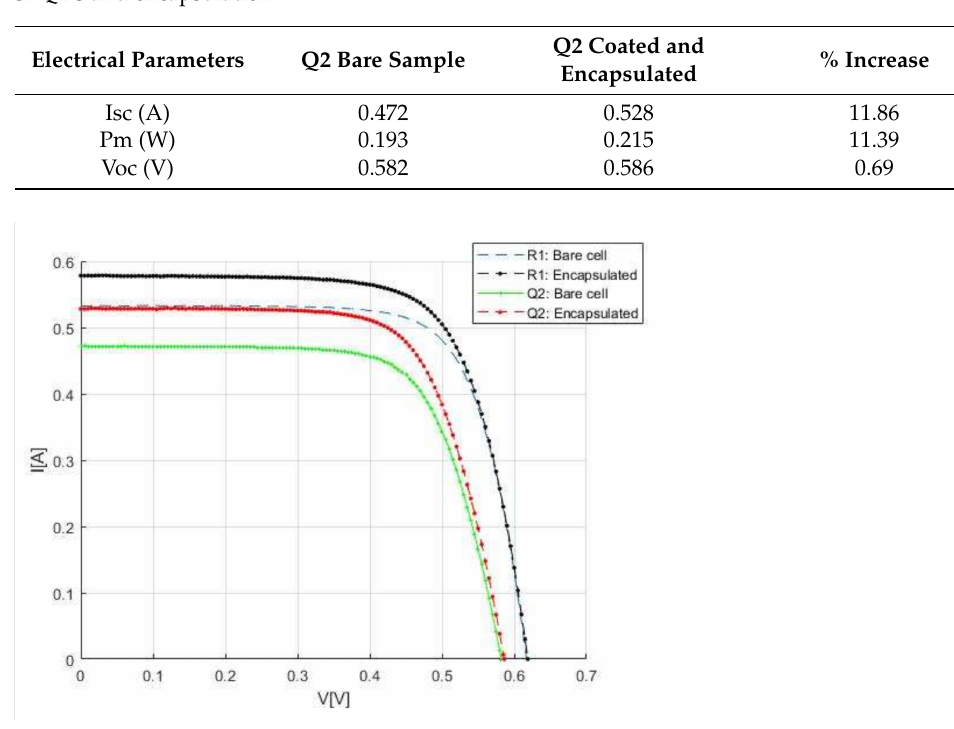
Figure 4. I-V characteristic of Q1 and Q2 samples before (bare cell) and after coated with PA Si-QDs. Table 3. Electrical parameters of Q2 sample before coating (bare cell) and after coating with PA Si-QDs and encapsulation.